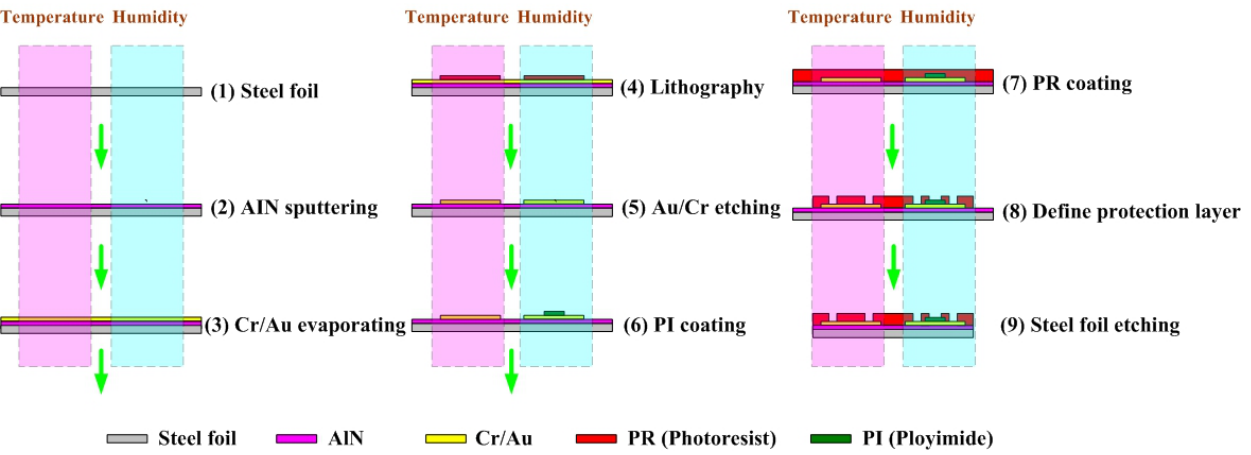
Figure 3. Fabrication of flexible micro sensors.